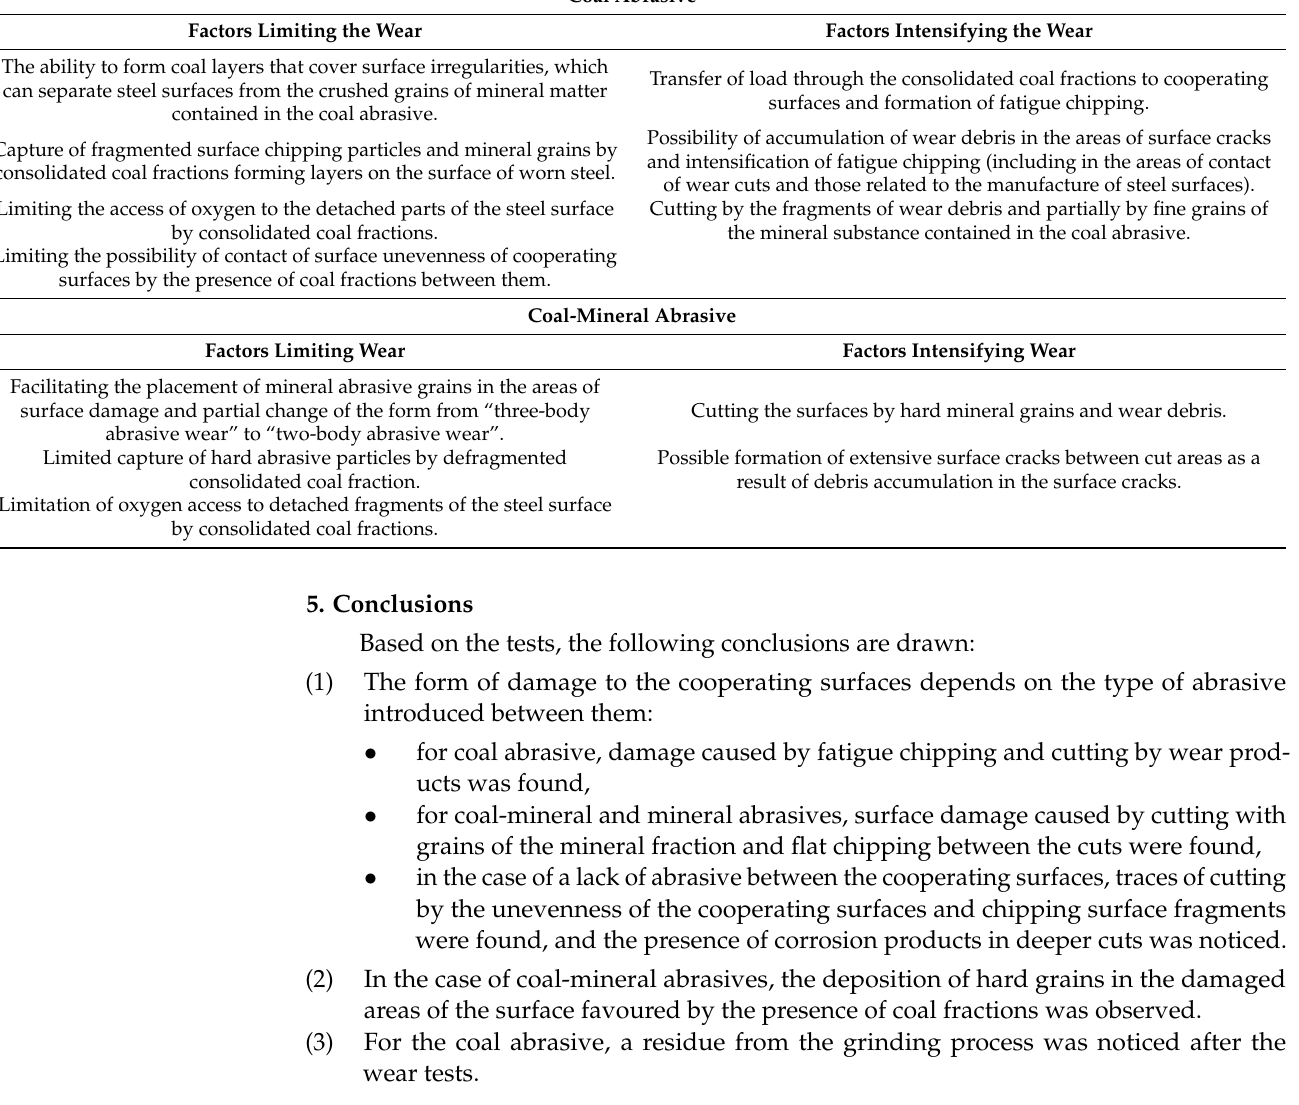
Table 7. List of factors limiting and intensifying the wear in the case of presence of coal and a coal-mineral mixture. Coal Abrasive Factors Limiting the Wear Factors Intensifying the